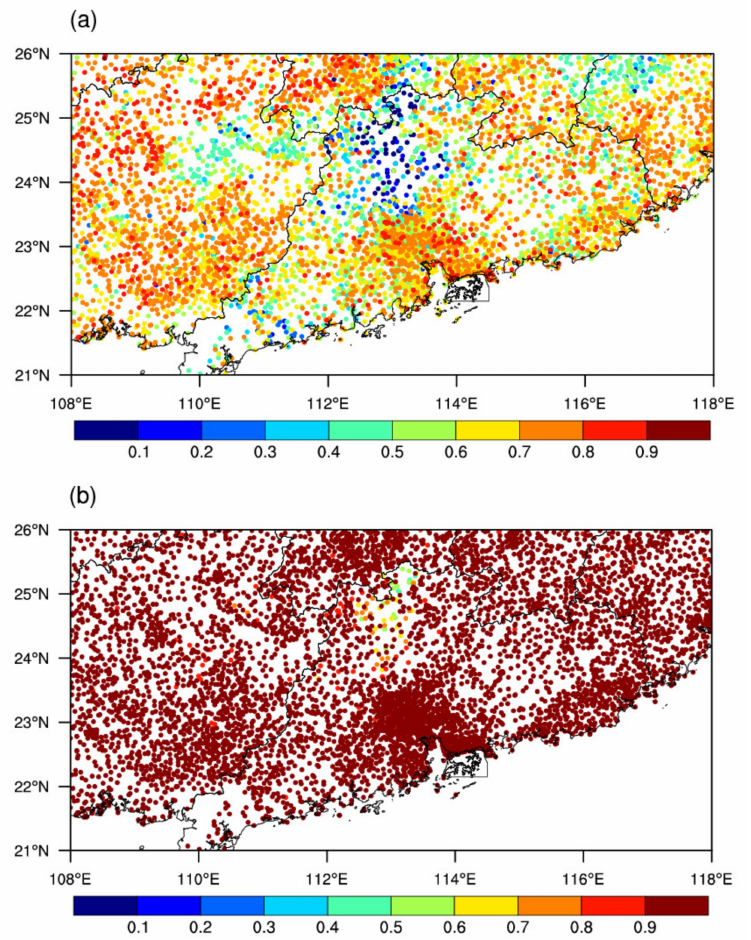
Figure 7. The spatial distribution of the correlation coefficients between the radar QPE product and AWS observational station rainfall ( a ) after correction by scaling and ( b ) after correction by Q-matching,